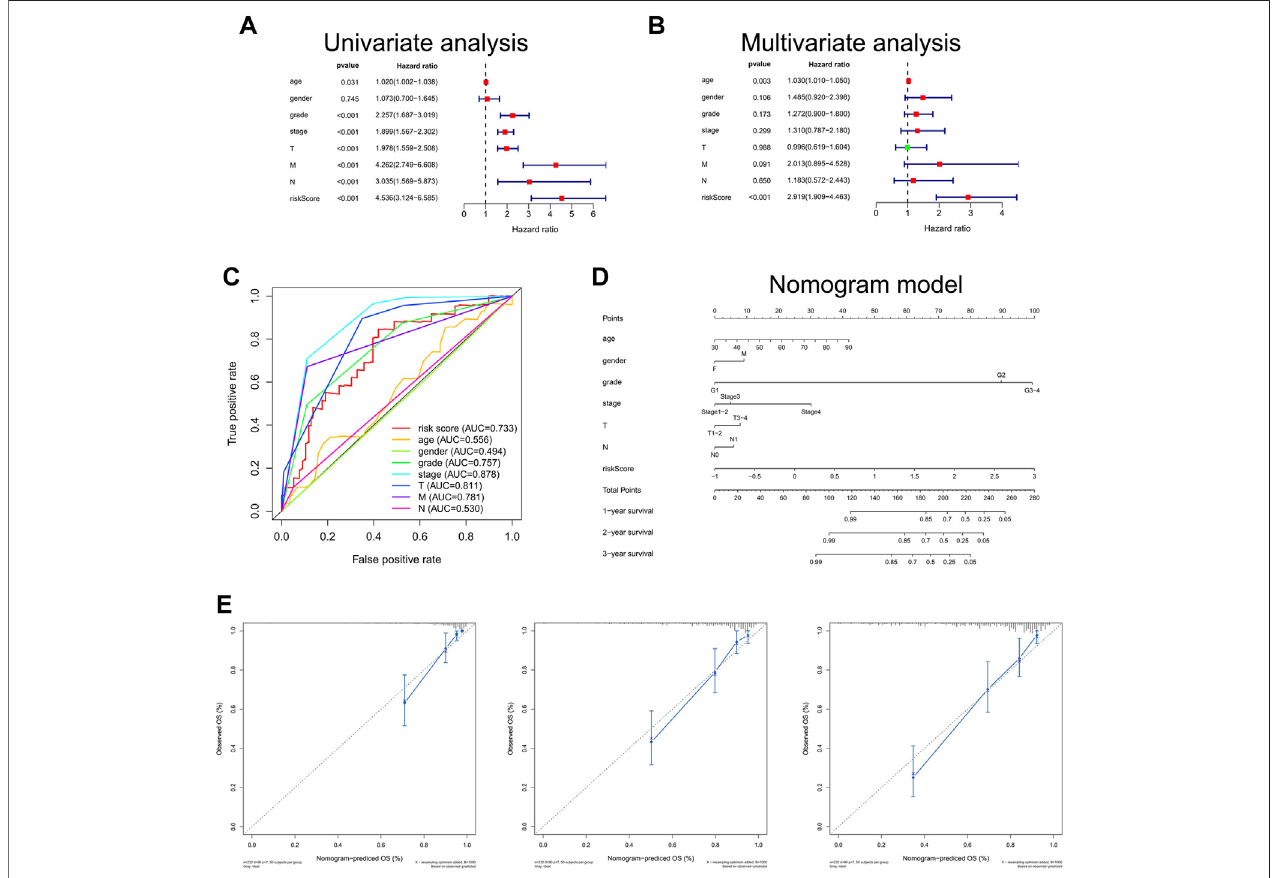
FIGURE4| Independentprognosticroleofriskscores.Univariate (A) andmultivariate (B) Coxregressionanalysesforriskscores. (C) ROCcurvesandAUCvalues forriskscore,age,gender,grade,stage,T,M,andN. (D) Nomogrambasedonriskscore,age,gender,grade,stage,T,andN. (E) Calibrationplotsofthenomogramfor predicting the probability of OS at 1, 2, and 3